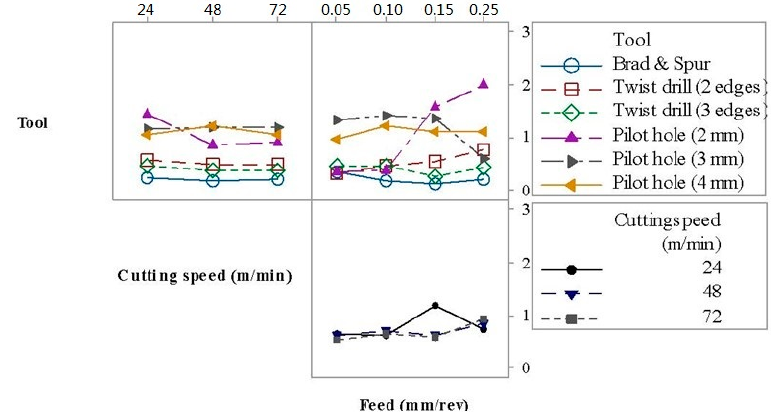
Figure 9. Interaction plot for burr height.